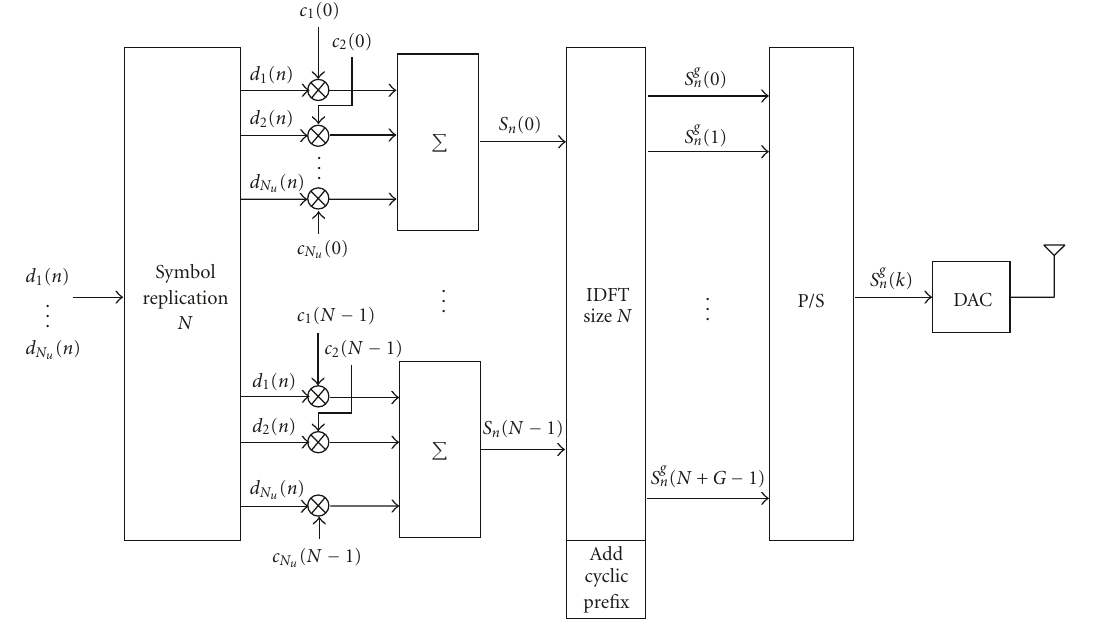
Figure 1: Block diagram of the MC-CDMA